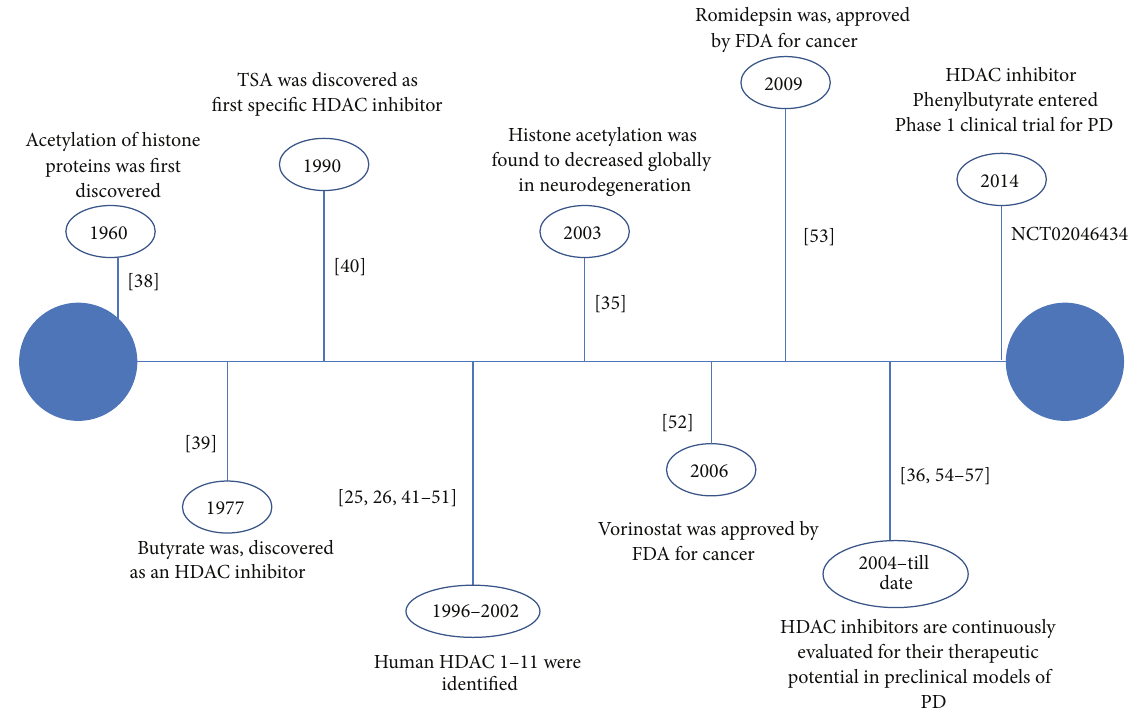
Figure 3: Historical aspects of HDACs and their